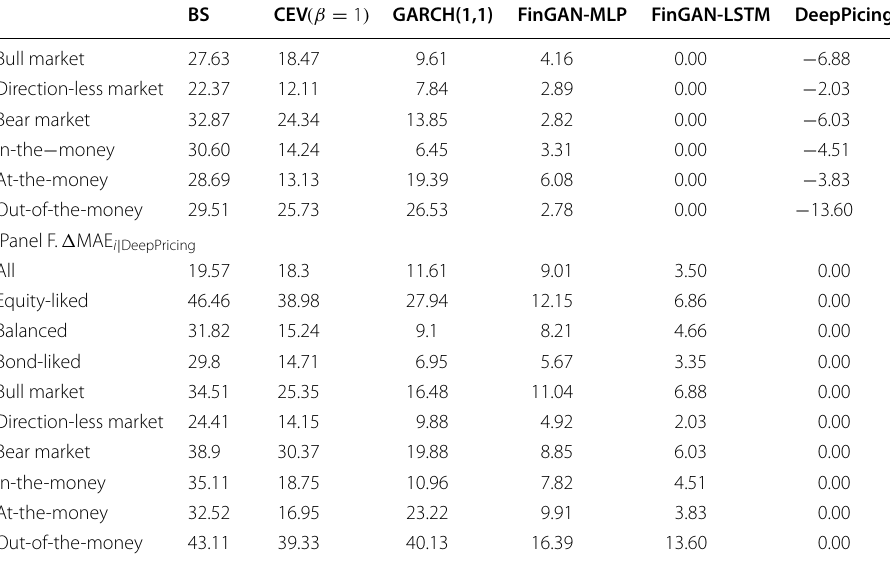
Table 5 shows the MAE performance metrics across the different models for robustness test. The metric MAE i stands for the percentage error of a model i as given by Eq. 45. The metric (cid:31) MAE i j measures the pricing performance difference of a | model i relative to a model j , which is defined by Eq. 46. The debt‑liked convertible bonds, the balanced convertible bonds and the equity‑liked convertible bonds is determined by the sensitivity of the convertible bond value to its underlying common stock and defined as (cid:31) (Eq. 23) belongingness to the intervals [0, 0.33]; [0.33, 0.66]; and [0.66, 1], respectively. Market states is classified by bull market including subperiod from January 01, 2014 to June 12, 2015 and subperiod from January 01, 2019 to June 30, 2021, bear market including subperiod from January 01, 2010 to December 31, 2013;